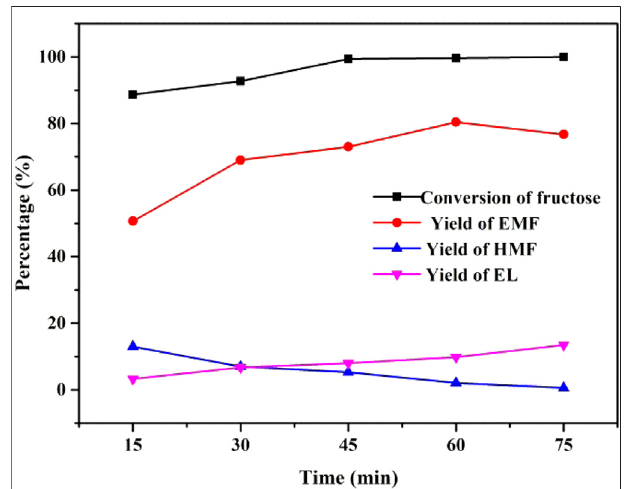
FIGURE 8 | Effect of reaction time on the alcoholysis of fructose. Reaction conditions: 1 mmol fructose, 5 ml ethanol, 30 mg catalyst, and 140 °